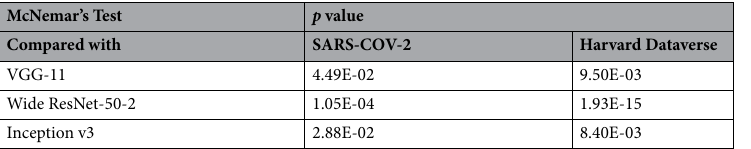
Table 8. Results of the McNemar’s Test performed on the individual models of the ensemble, on both datasets: Null hypothesis is rejected for all cases.